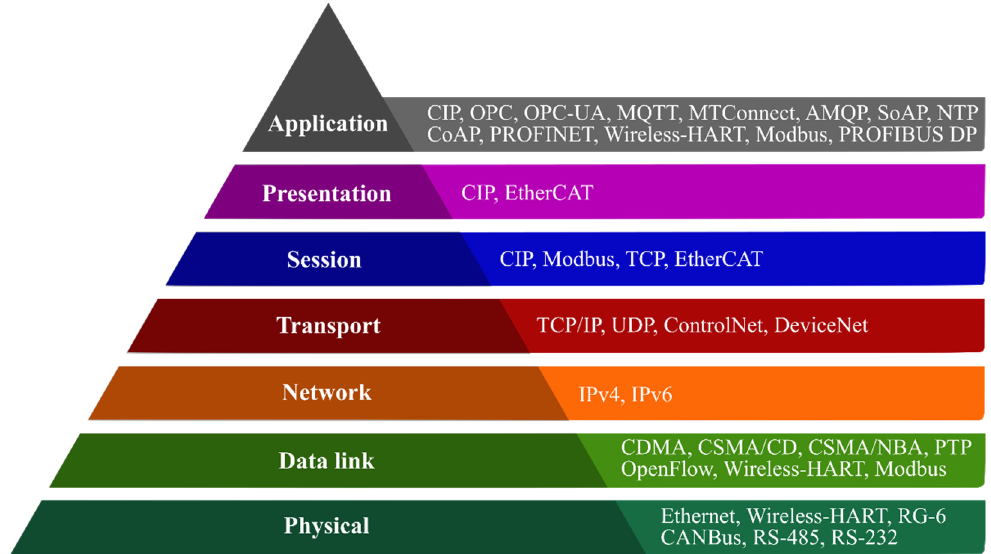
Figure 2. Communication layers and protocols.